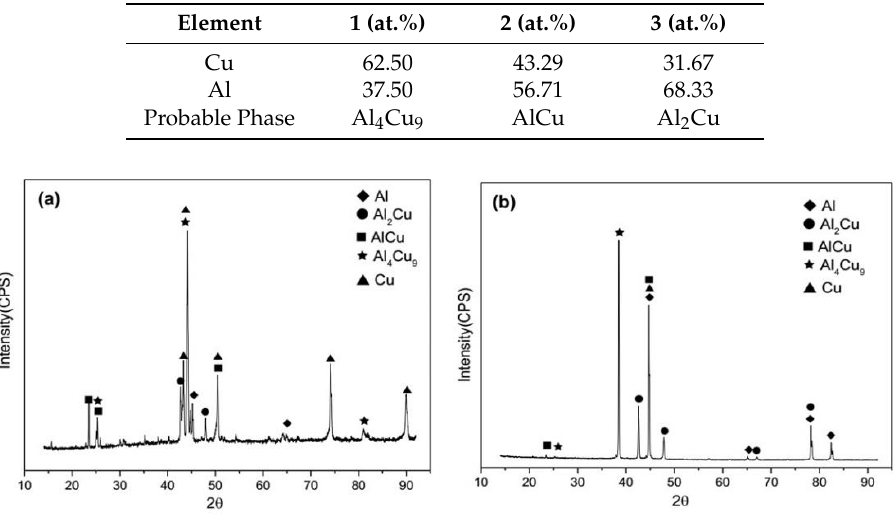
Figure 4. XRD pattern of the peeled surface for the as-cast Cu/Al clad sheet: ( a ) Cu side and ( b ) Al side.